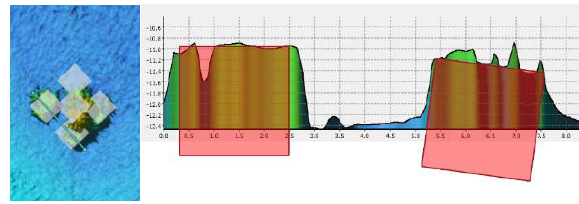
Figure 7. Estimating AR unit burial by measuring cross section on the 3D surface surrounding the blocks. Red areas show approximate shape and dimension of the AR concrete blocks